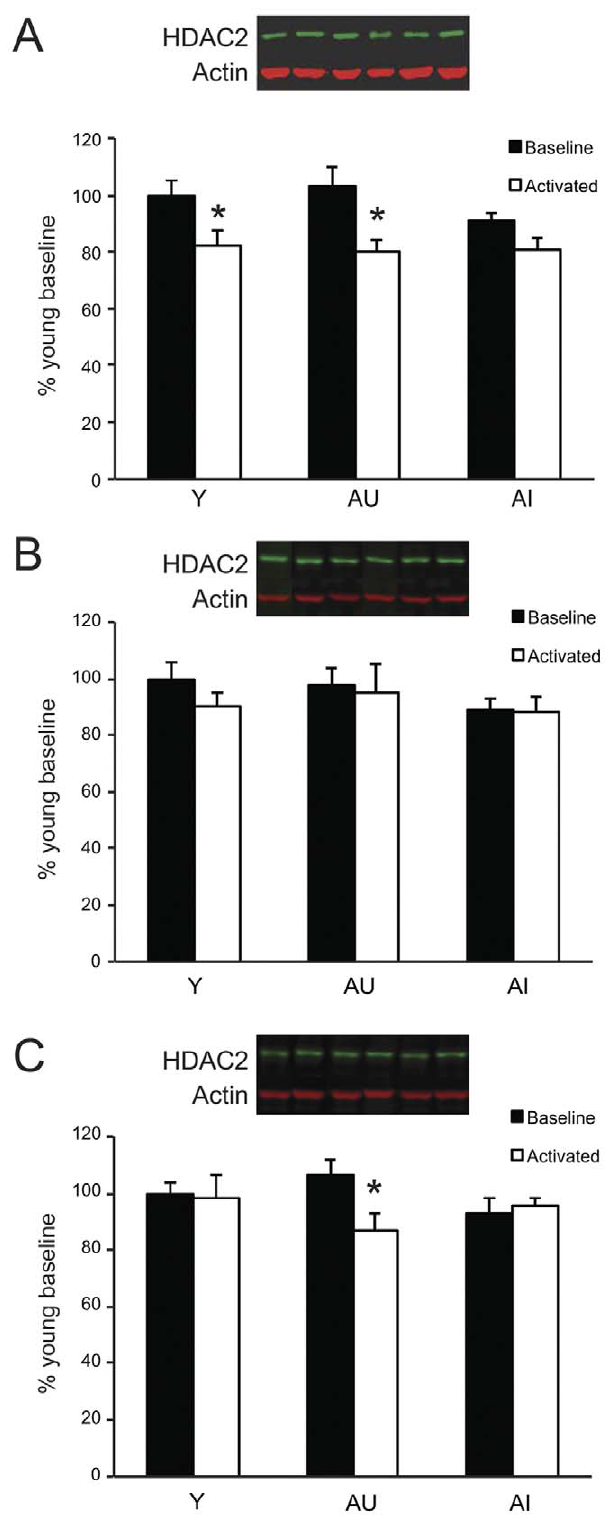
Figure 3. HDAC2 is regulated in relation to cognitive aging, recent experience and hippocampal region. (A–C) Quantification of HDAC2 levels in regions CA1 (A), CA3 (B) and DG (C). Representative western blots are organized according to the corresponding quantita- tive results. Protein levels were normalized to b -actin and the group data are represented as a percentage of young baseline values. Error bars=S.E.M. Asterisks denote p , 0.05 relative to respective baseline.